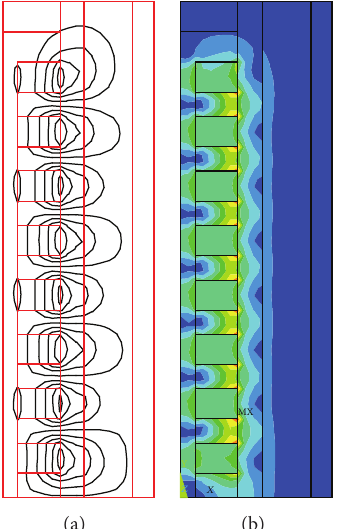
Figure 8: Finite element analysis of the linear power generator: (a) magnetic flux distribution and (b) magnetic flux density.